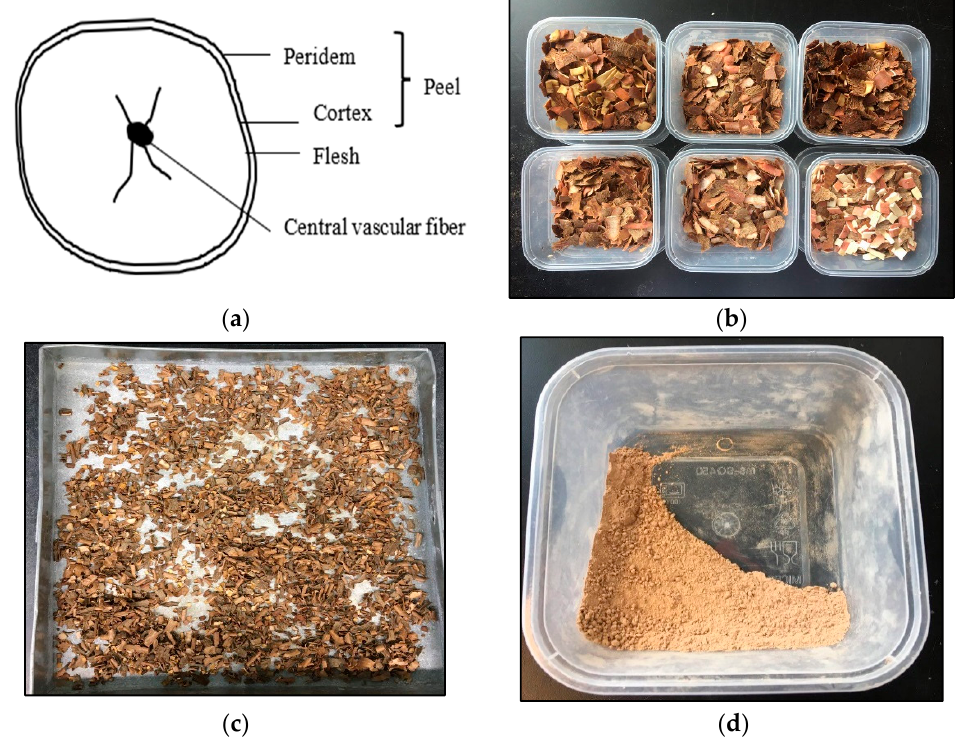
Figure 1. ( a ) Cross section of cassava; ( b ) Cassava peels before being dried; ( c ) Cassava peels after being dried; ( d ) Powdered cassava peels.